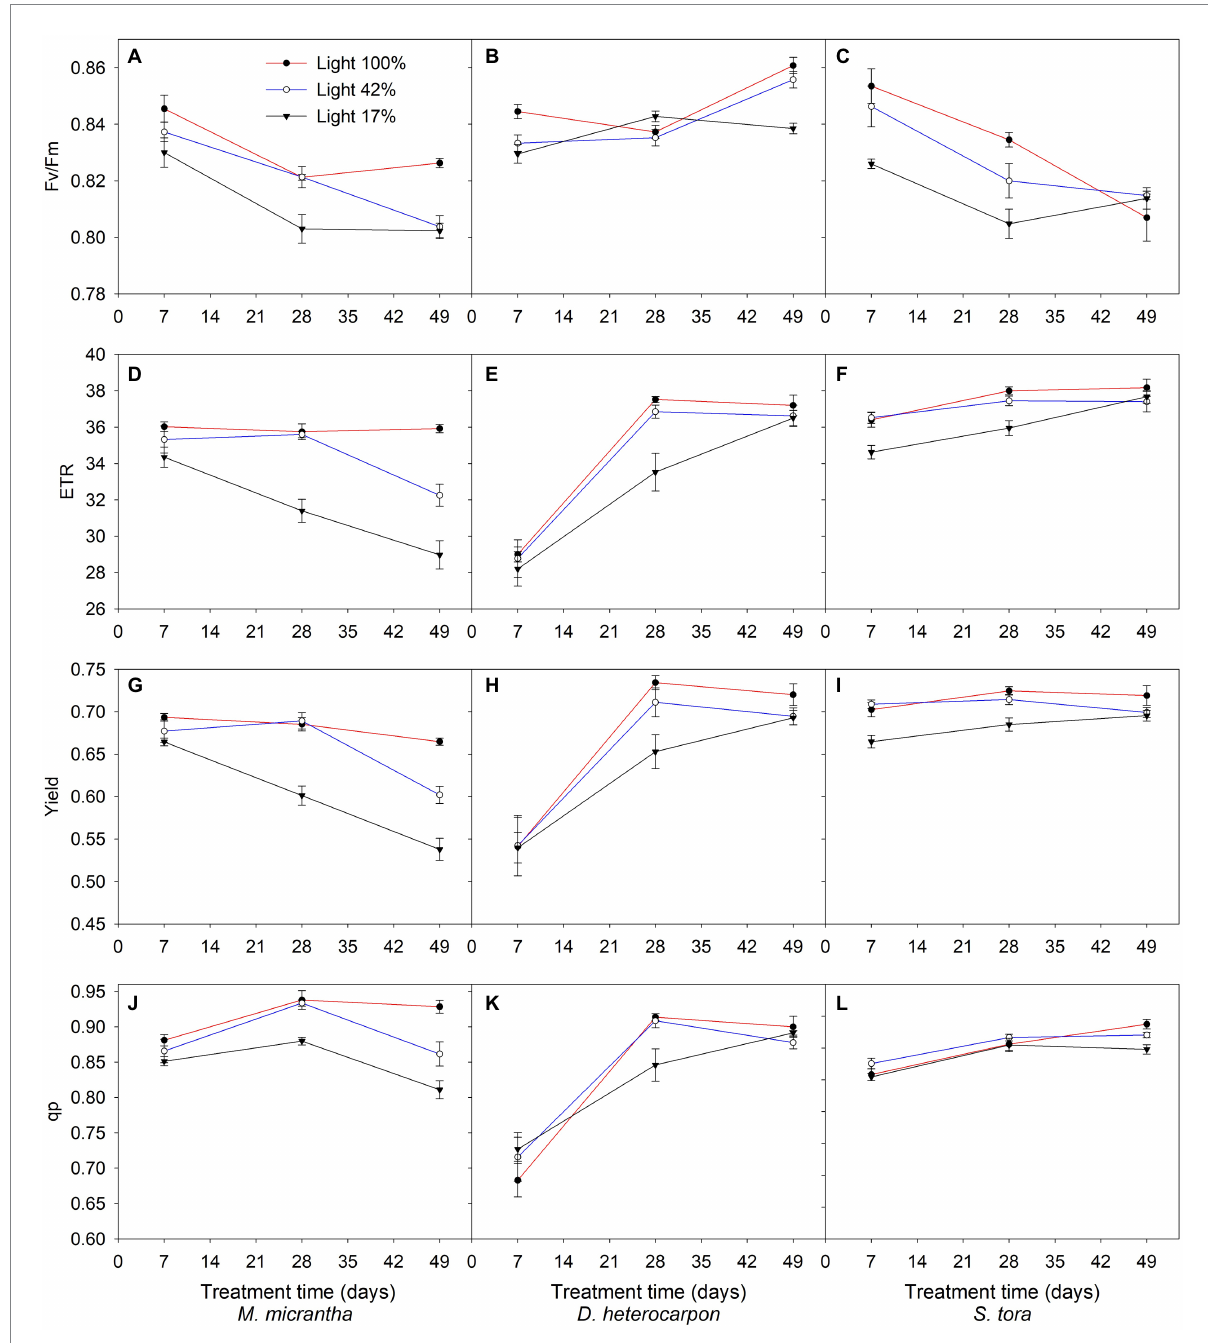
FIGURE 4 Changes of chlorophyll fluorescence parameters of two replacement forage legumes and M. micrantha under different light treatments (average ± SE, n = 3). (A, D, G, J) M. micrantha ; (B, E, H, K) D. heterocarpon ; (C, F, I, L) S. tora